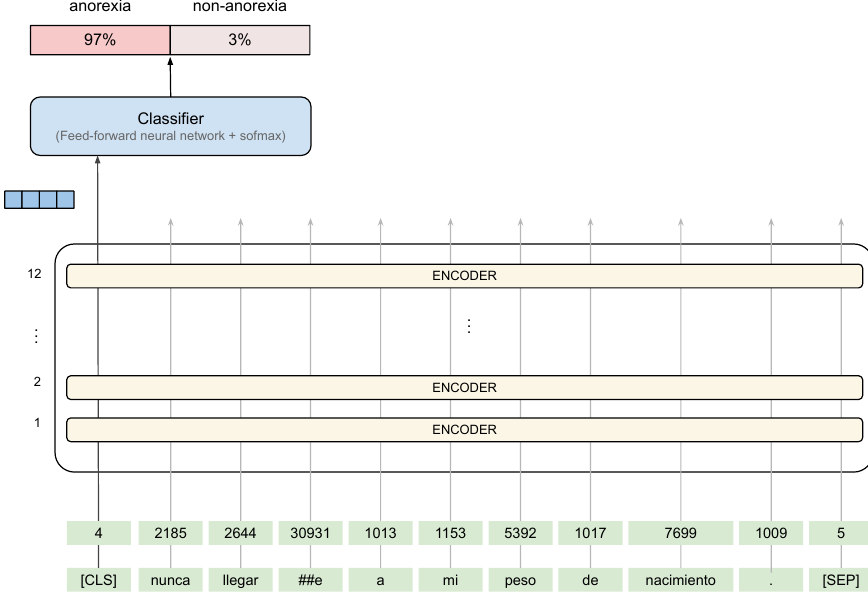
Figure 4. The architecture of